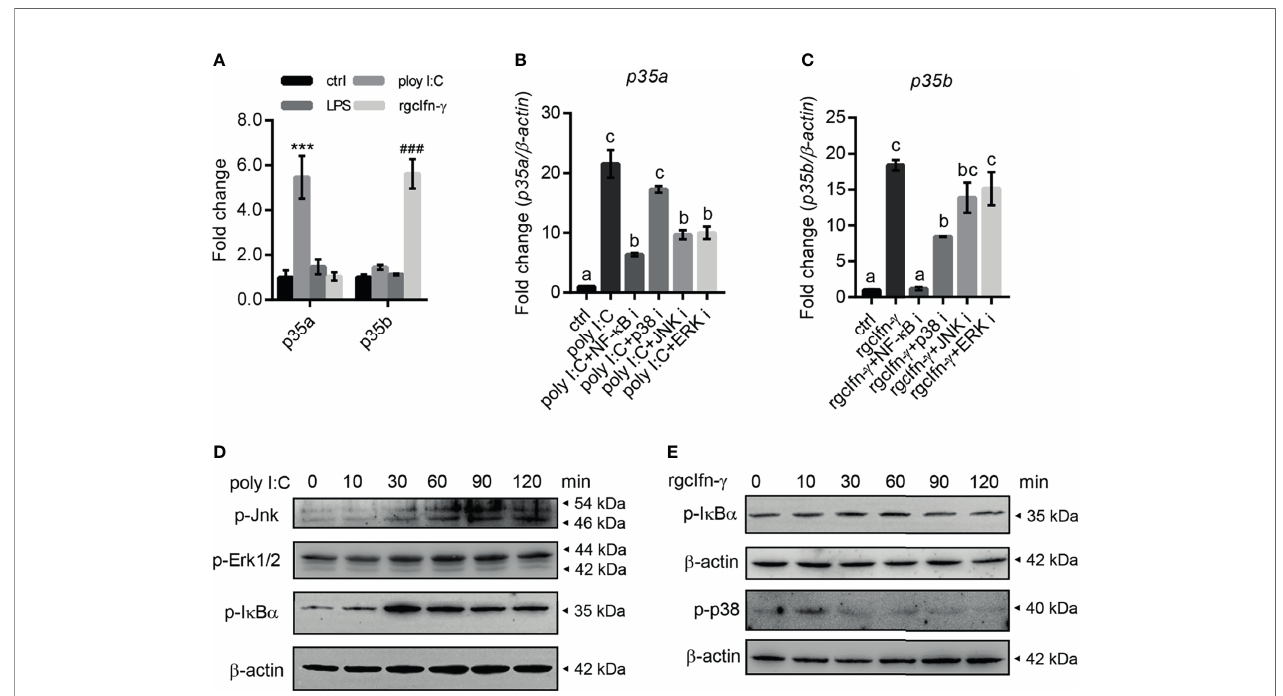
FIGURE 2 | Inductive expression of gcp35a and gcp35b transcripts after different immune challenges in grass carp monocytes/macrophages. (A) The monocytes/ macrophages were treated with poly I:C (50 µg/mL), LPS (30 µg/mL) and rgcIfn- g (500 ng/mL) for 6 h. *** p < 0.001 ( vs . p35a ctrl), ### p < 0.001 ( vs . p35b ctrl). Data are shown as mean ± SEM (N = 4). (B, C) The inhibitors for p38 (SB202190, 30 µM), JNK (SP600125, 6 µM), ERK (PD98059, 30 µM) and NF- k B (PDTC, 0.25 µM) were added with poly I:C (50 g/mL), or rgcIfn- g (500 ng/mL) for 12 h, separately. The gcp35a and gcp35b mRNA was normalized relative to b -actin and expressed as fold changes compared with the control group. Different letters indicate signi fi cant differences at p < 0.05. Data are shown as mean ± SEM (N = 4). Activation of Jnk, Erk1/2 and I k B a by poly I:C (50 µg/mL) (D) and I k B a and p38 by rgcIfn- g (500 ng/mL) (E) for 0, 10, 30, 60, 90 and 120 min in grass carp monocytes/